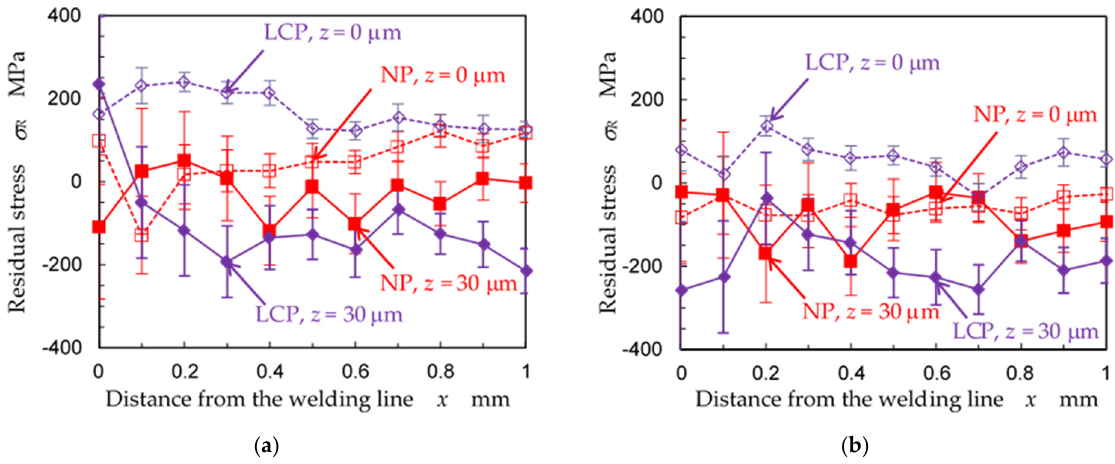
Figure 11. Residual stress at the surface z = 0 μ m and z = 30 μ m of non-peened (NP) and laser cavitation-peened (LCP) specimens. ( a ) x -direction; ( b ) y -direction.